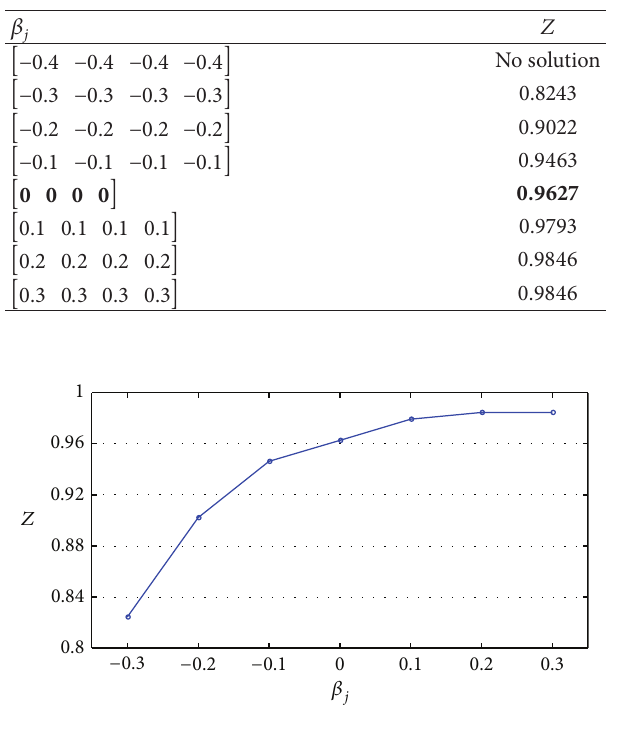
Figure 4: Curve of 𝑍 changed with 𝛽 𝑗 .